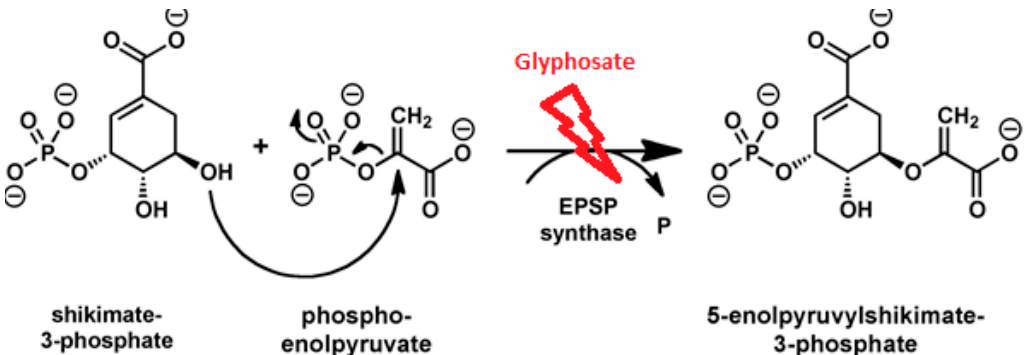
Figure 1. Schematic representation of binding of glyphosate to the substrate-binding site of the EnolPyruvylShikimate-3-Phosphate Synthase (EPSPS), inhibiting its activity, and blocking its importation into the chloroplast.